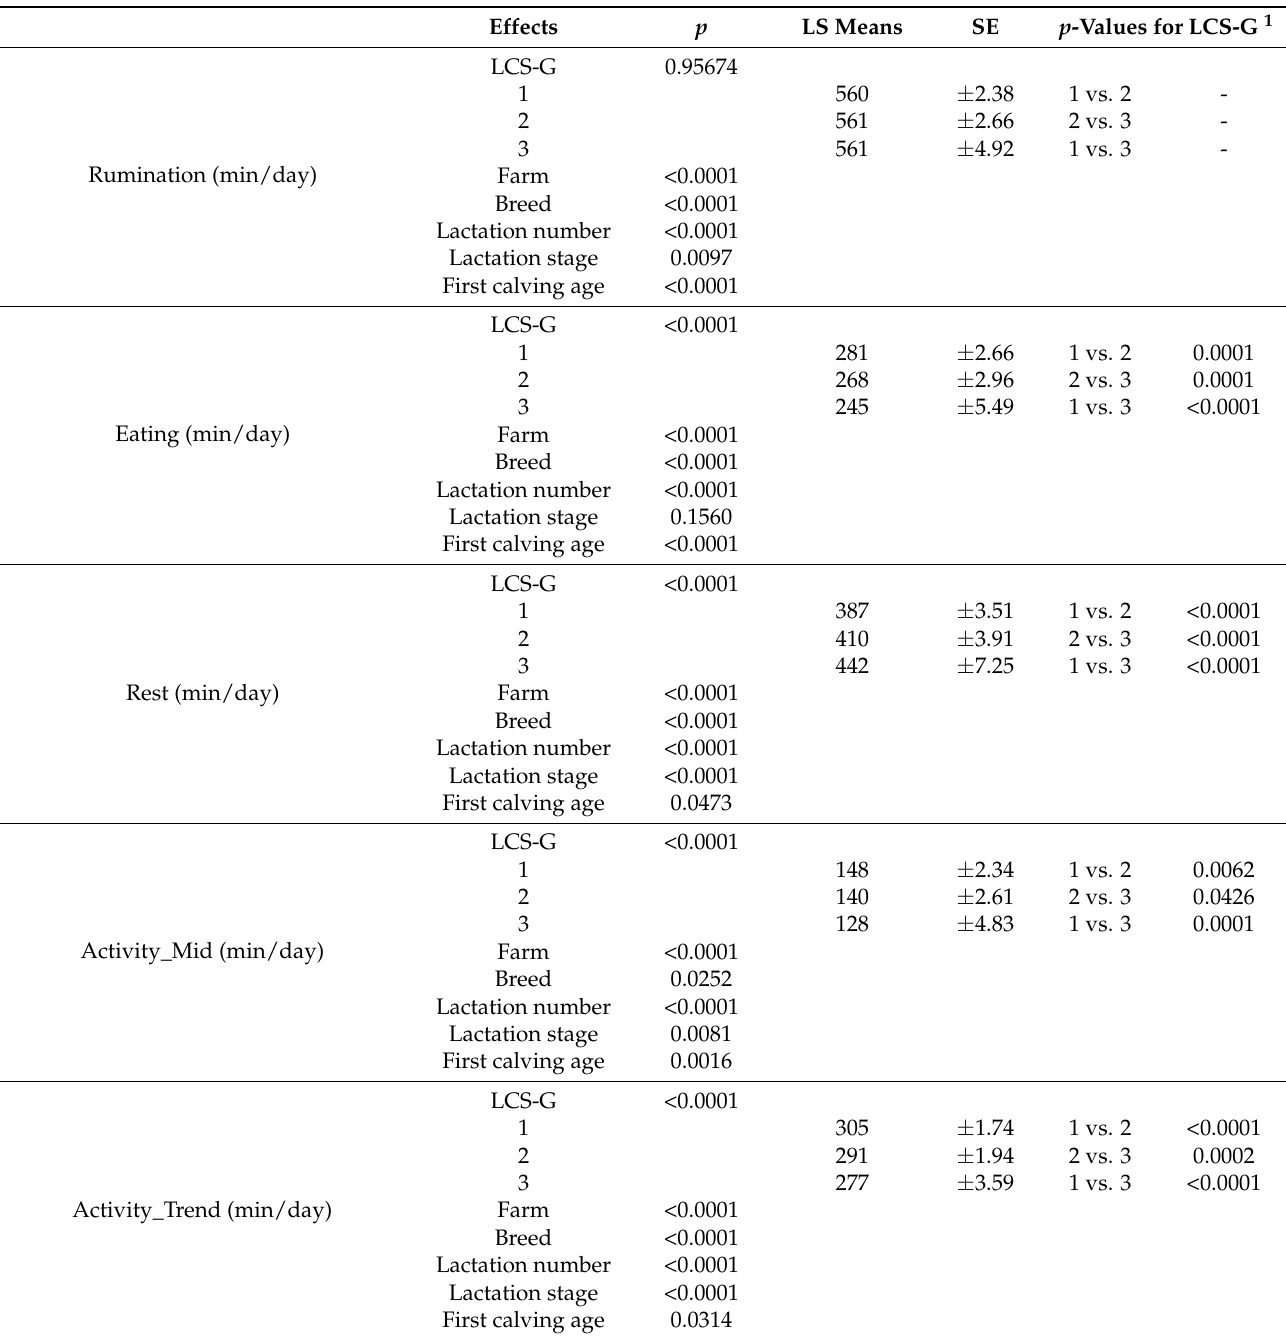
Table 8. Detailed results for sensor parameters according to LCS groups; LCS-G 1–3: locomotion score groups 1 to